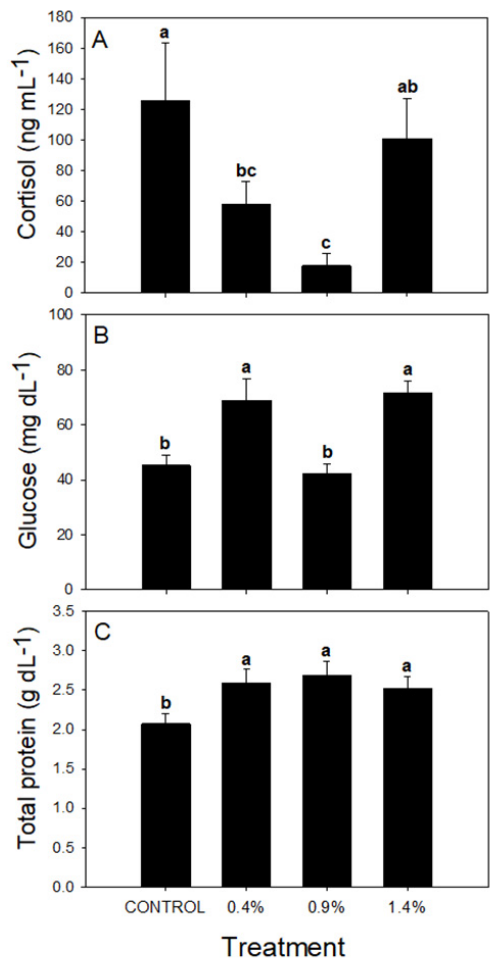
Figure 2. Serum cortisol ( A ), glucose ( B ), and total protein ( C ) levels in S. dorsalis fed with different experimental diets. Different letters represent significantly different values ( p < 0.05) between different treatments ( n = 6).